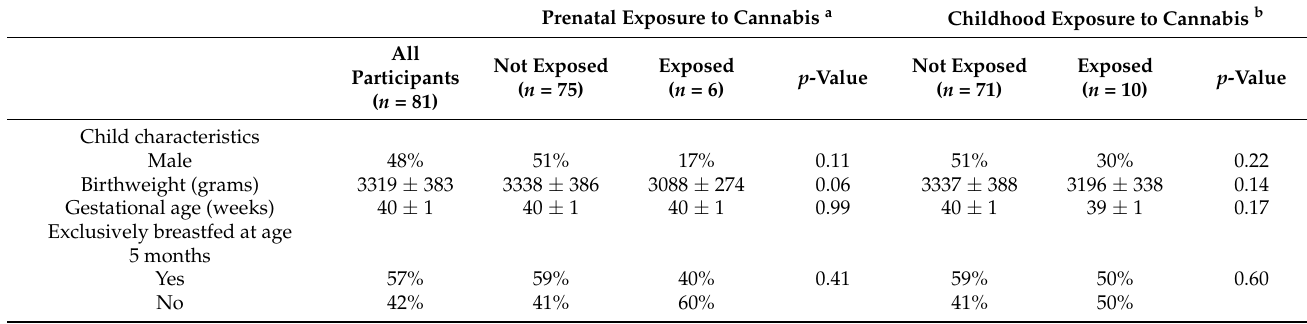
Table 1. Cont . Prenatal Exposure to Cannabis a Childhood Exposure to Cannabis